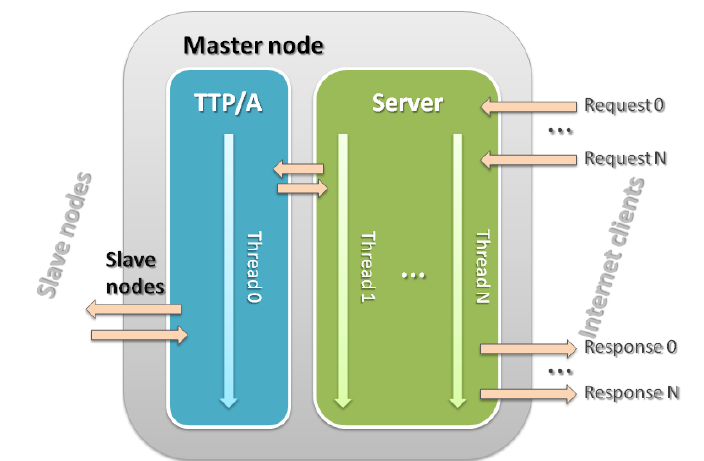
Figure 8. Architecture of the master